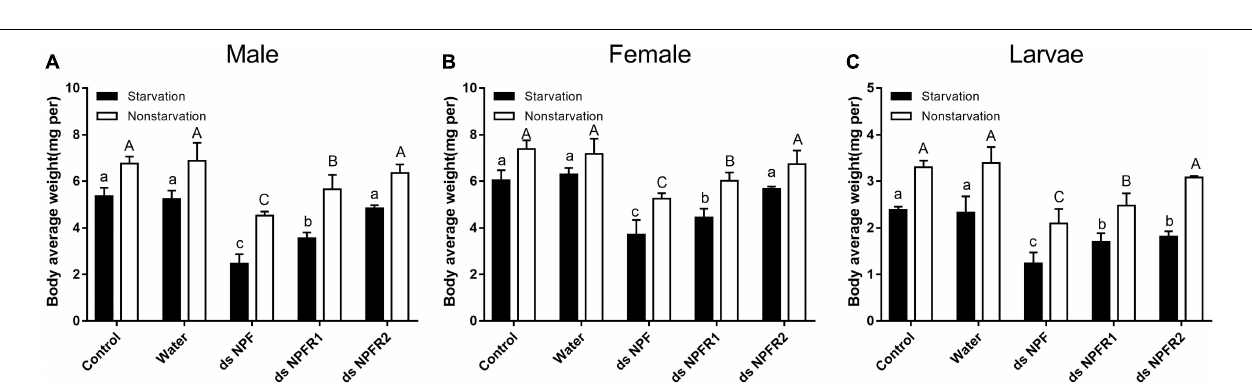
FIGURE 5 | Mortality responses of RNAi D. armandi male (A) , female (B) , and larvae (C) in starvation and male (D) , female (E) , and larvae (F) in non-starvation to different time points. Mortality responses of dsRNA-treated, water-injected, and non-injected in D. armandi to different time points (0, 12, 24, 36, 48, 60, and 72 h). All experiments were analyzed by Student’s t -test, and in (A–F) , experimental beetles significantly differed ( P < 0.01) from two controls.